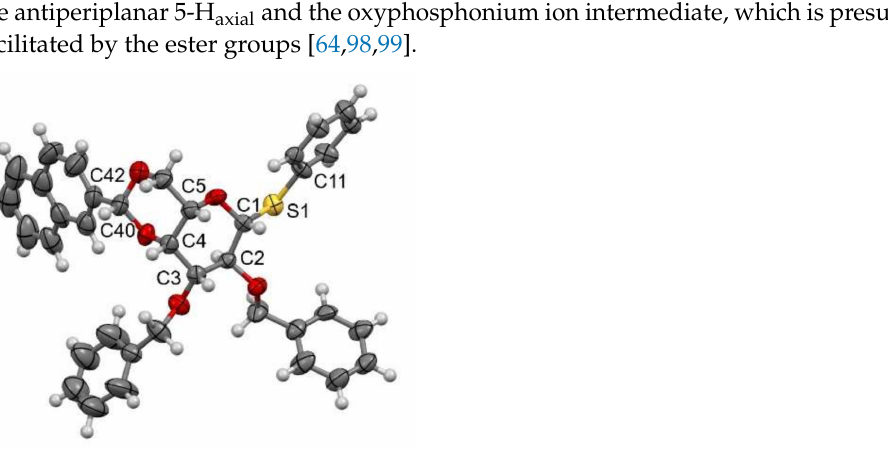
Figure 2. ORTEP view of compound 83 at 40% probability level for better visibility with partial numbering